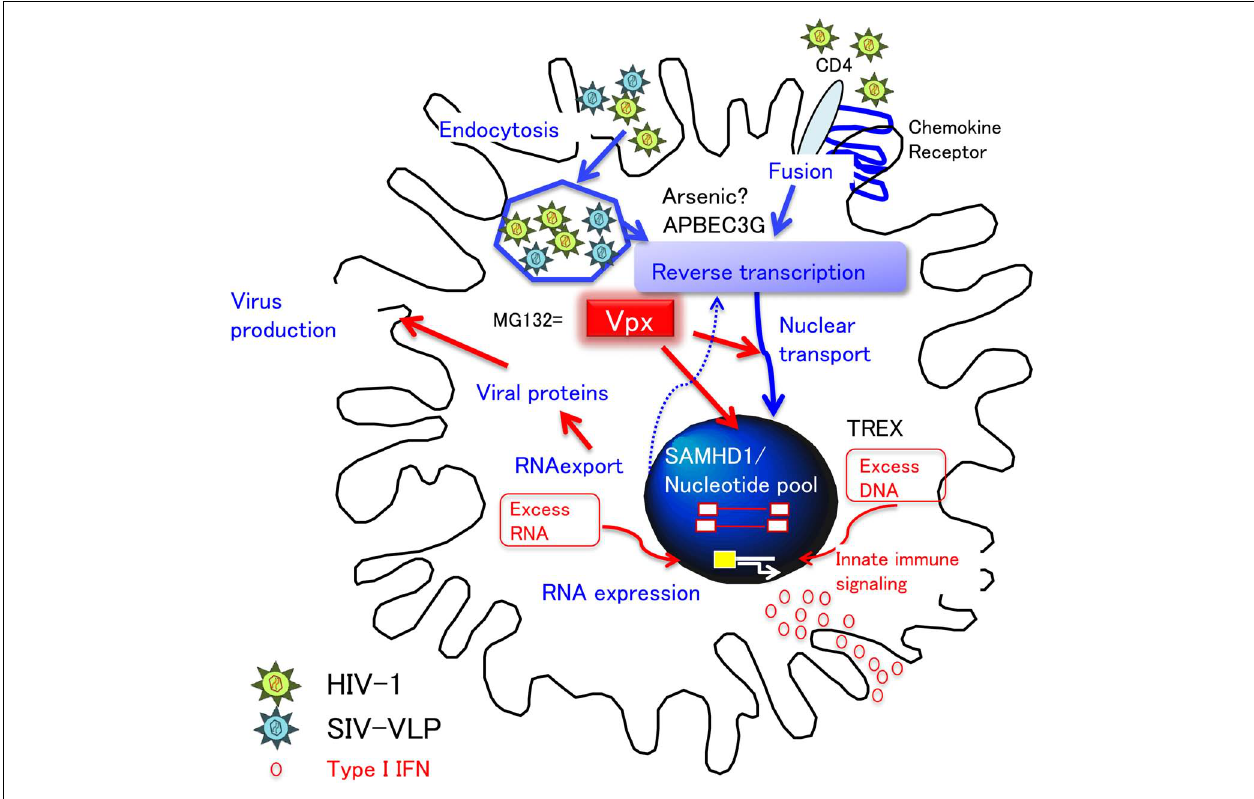
FIGURE 4 | DC restriction and type I IFN response. HIV-1 utilizes CD4 and chemokine receptors for entry.The restriction of cDC to HIV-1 infection occurs at the entry (fusion) and post-entry level. Of note, in order to investigate the step at the post-entry level,VSV-pseudotyped virus is frequently utilized, which enters cells by endocytosis. After entry, APOBEC3G and arsenic sensitive factor inhibit reverse transcription. However,Vpx can counteract this restriction in DC by either degrading (1) SAMHD1-nucleotide pool-reverse transcription pathway or